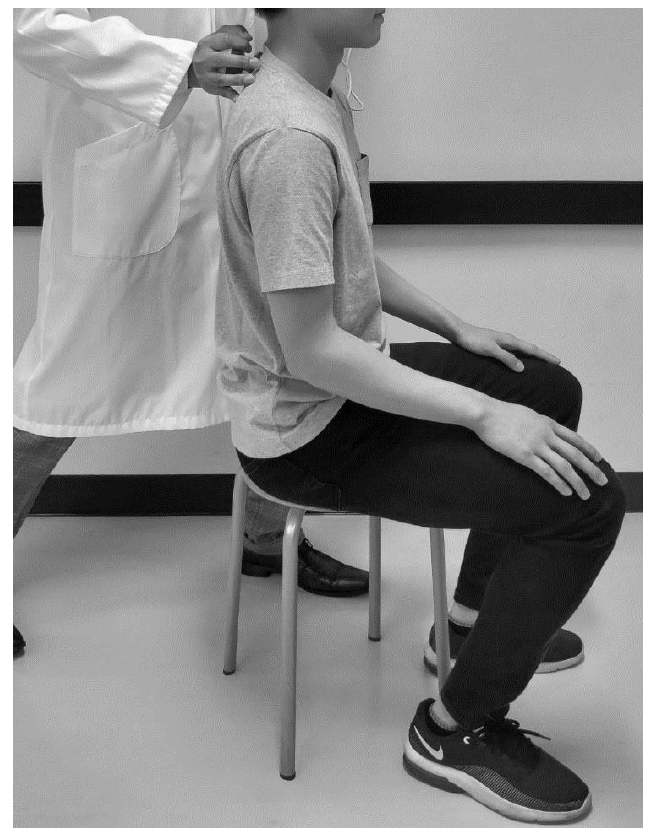
Figure 1. Experimental setup. Maximum isometric extension strength of the trunk muscle while in the sitting position with a 0° lumbar extension. Written informed consent was obtained from the participants before the publication of the image.